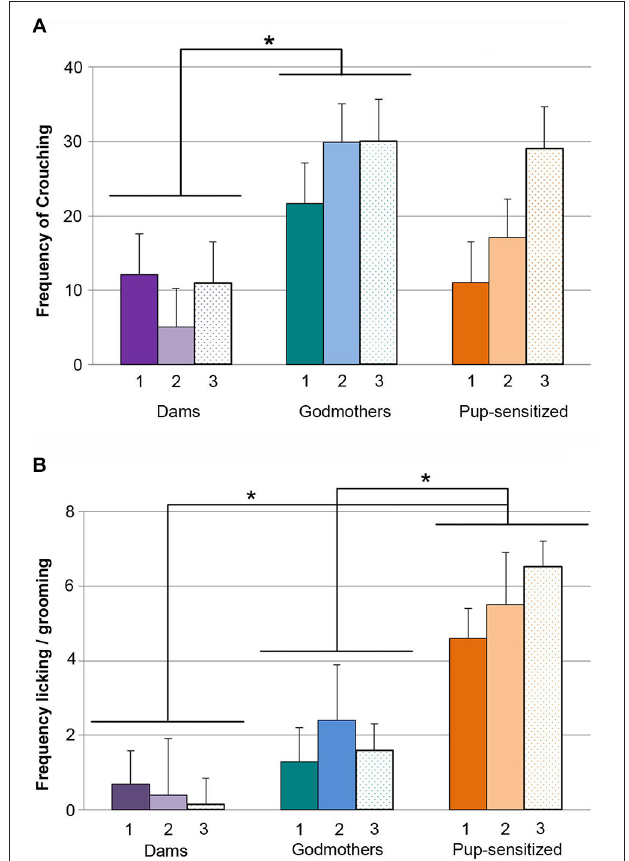
FIGURE 3 | Godmothers and pup-sensitized females differentially expressed crouching and licking/grooming. Number of observations (out of 40 possible events) of crouching and licking/grooming during the 10 min period of observation (A) Godmothers displayed crouching more frequently than dams but not than pup-sensitized females. (B) Pup-sensitized females showed pup licking/grooming more frequently than dams and godmothers. * p <